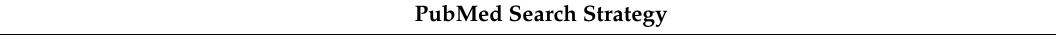
Table 2. Search Strategy. PubMed Search